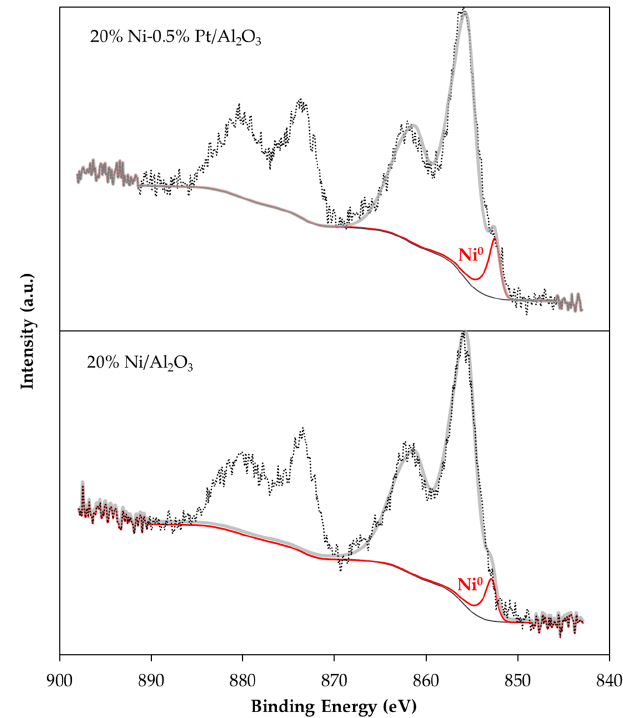
Figure A3. Nickel 2p X-ray photoelectron spectra of 20% Ni/Al 2 O 3 and 20% Ni-0.5% Pt/Al 2 O 3 after reduction under H 2 at 400 °C. Catalysts 2018 , 8 , x FOR PEER REVIEW